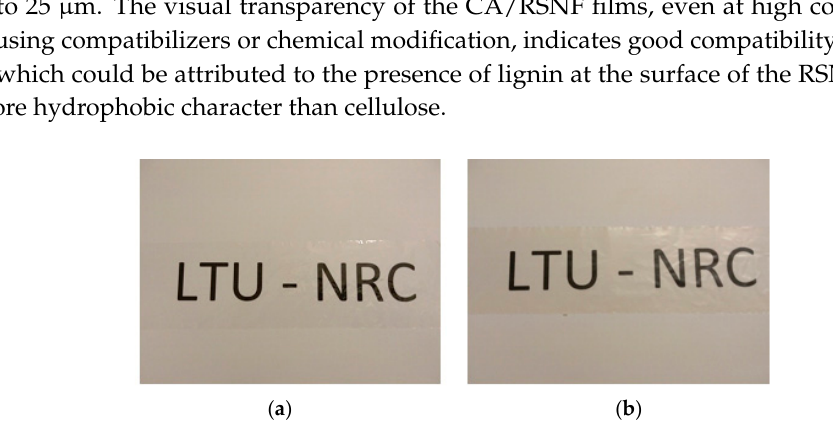
Figure 4. Photos of neat CA ( a ) and CA/10% RSNF films ( b ) over a printed paper.